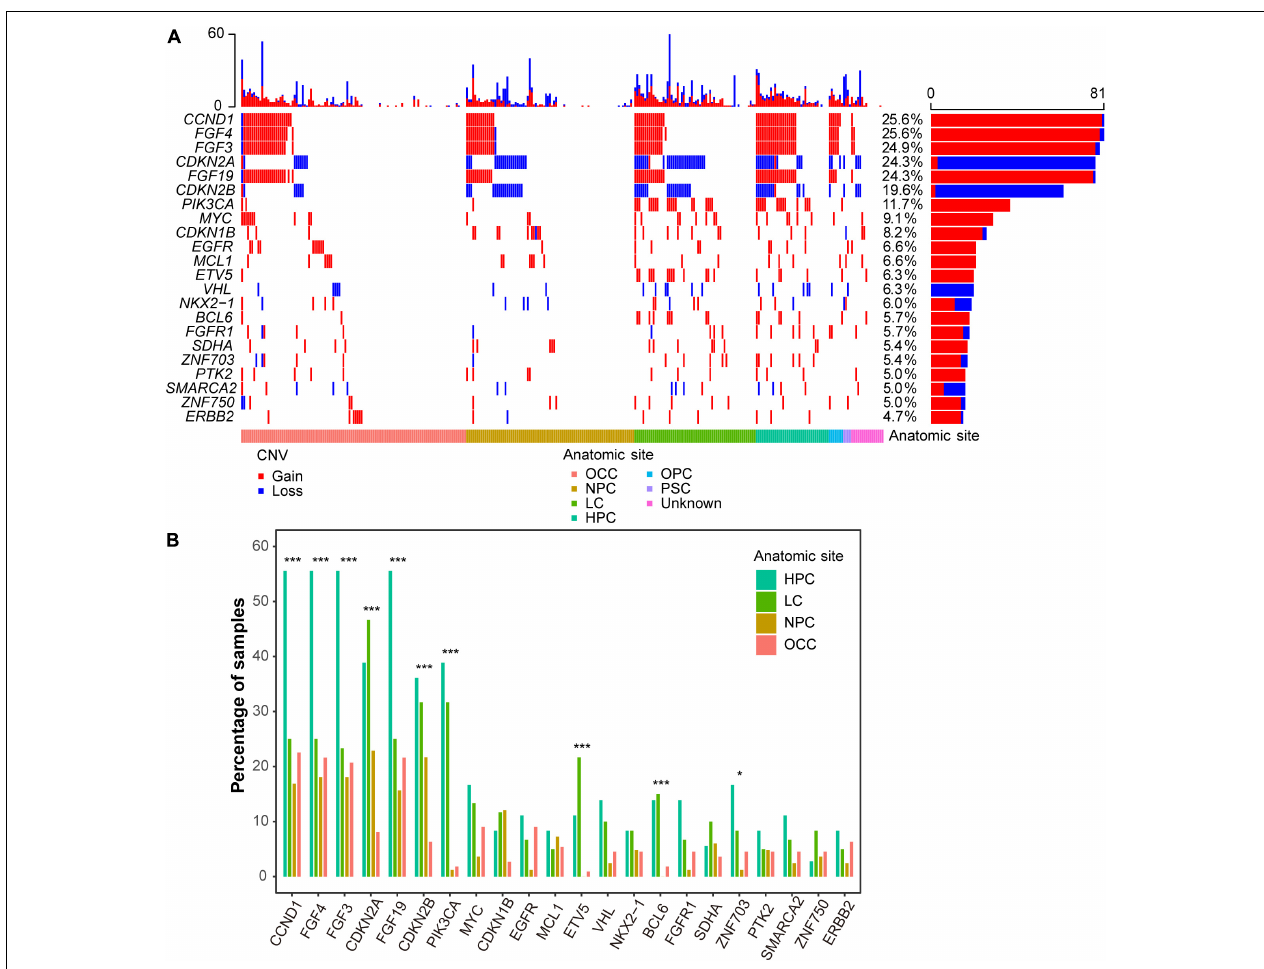
FIGURE 2 | CNV landscape of Chinese HNSCCs across different anatomic sites. (A) Waterfall plot of top 22 frequent CNV genes. Each row indicates a gene, and each column represents a patient. Patients are sorted by anatomic site. Bars on left show number of samples with CNV in genes, whereas bars on top represent number of CNV for samples. Copy number gain and loss are represented in red and blue. (B) CNV frequency of recurrent genes by anatomic sites. Anatomic sites are shown in different colors. * p < 0.05, *** p < 0.001.